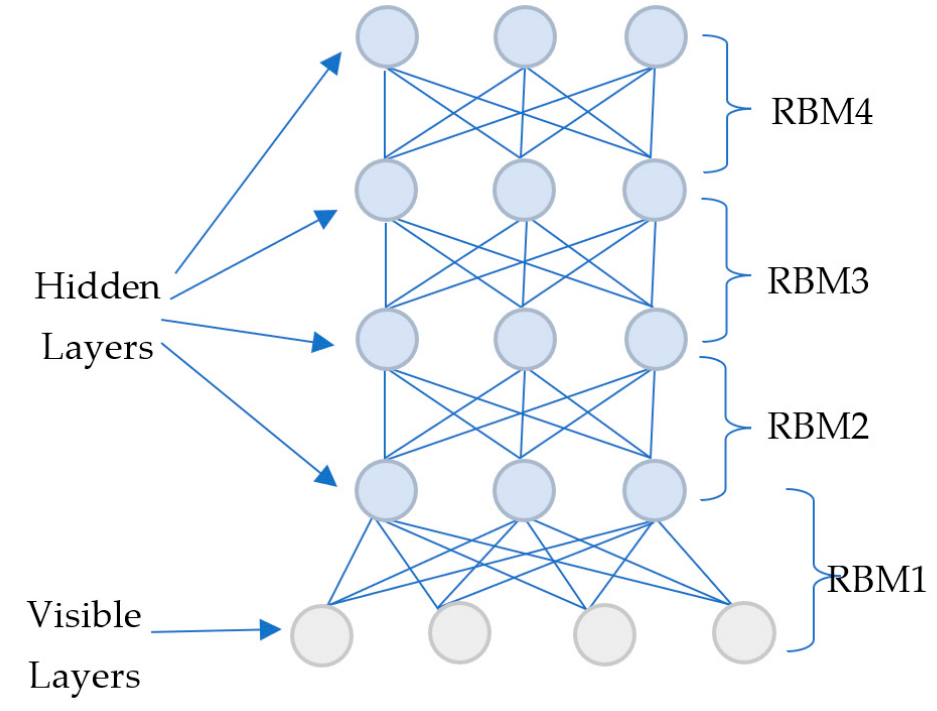
Figure 13. A representation of a deep belief network [56].